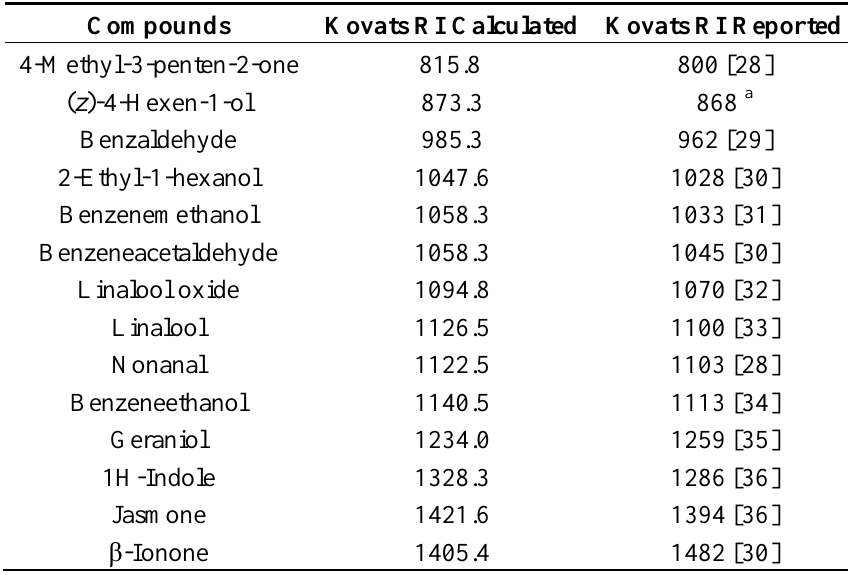
Table 3. Fourteen volatile compounds found in six Korean green teas and Kovats retention indices calculation for the